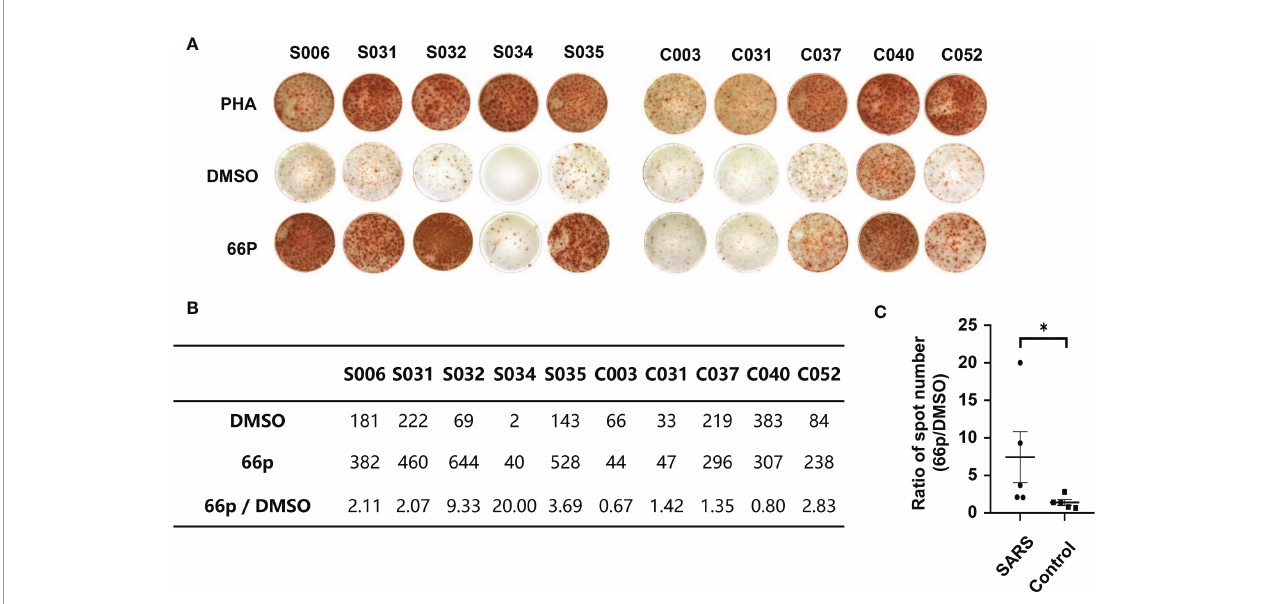
FIGURE 2 | T-cell immune response detected using the IFN- g ELISPOT assay. (A) ELISPOT assay of PBMCs obtained from convalescent patients with SARS and control populations. PHA and DMSO were the positive and negative controls, respectively. (B) Table containing spot count from (A) . (C) Graph depicting statistical analysis of (B) ; *P <